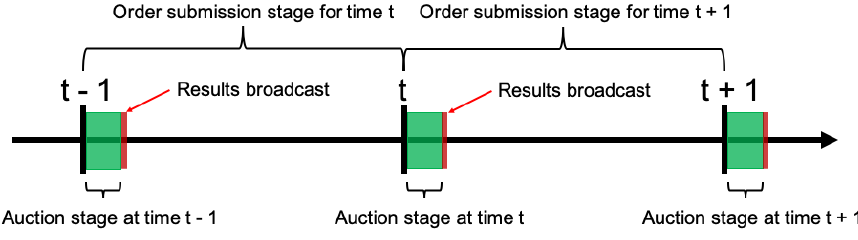
Figure 1. Process flow for frequent batch auctions. Adapted from